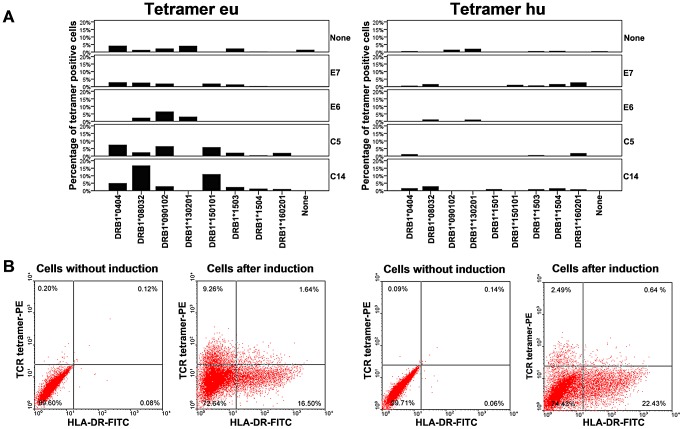
Flow cytometric analysis of the binding of TCR tetramers to artificial APCs.(A) The X-axis indicates APCs with different HLA-DR alleles and Y-axis indicates the percentages of tetramer-positive APCs induced by different MTB-specific peptides (E7, E6, C5, and C14). On the X-axis, “none” indicates non-induced cells or cells that only expressed HLA-DR without the peptide listed on the Y-axis. (B) Examples of dot plots showing the binding of TCR tetramers with artificial APCs. Only the background stainings of the non-induced cells were shown (0.32% for eu and 0.23% for hu). Positive stainings by either the tetramers in cells expressing C14/HLA-DR following induction (10.90% in C14/HLA-DRB1*150101 stained with eu and 3.13% in C14/HLA-DRB1*08032 stained with hu), were observed. The expression of HLA-DR was confirmed by staining with the anti-HLA-DR antibody (L243-FITC). Because the binding of the TCR tetramers to peptide/HLA-DR complexes could be competitively blocked by L243, small cells appeared in the upper right quadrant of the dot plots.